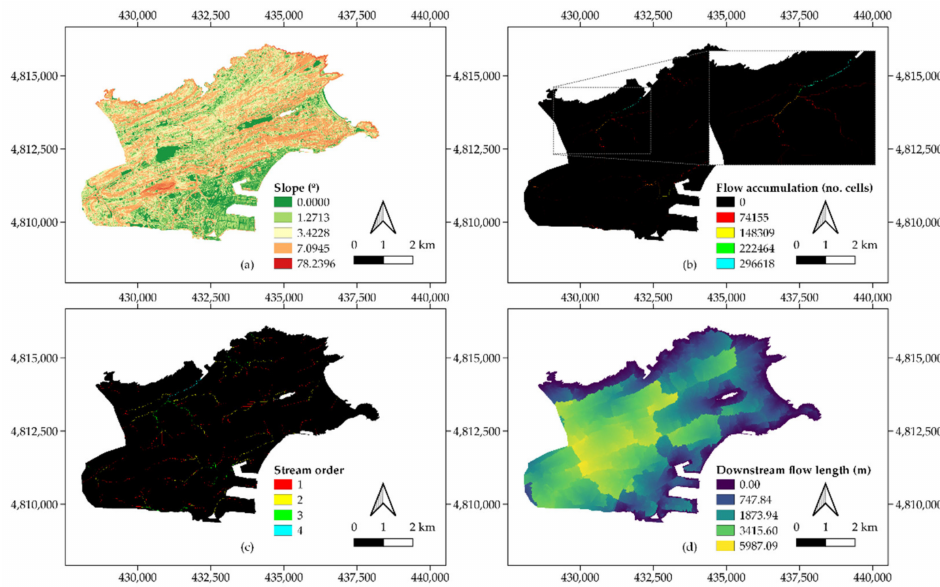
Figure 4. Intermediate output layers, ( a ) slope, ( b ) flow accumulation, ( c ) stream order, and ( d ) down- stream flow